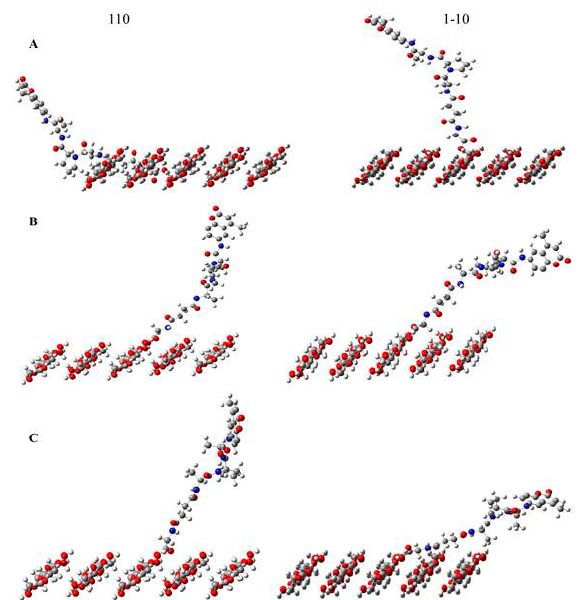
Figure 8. The tripeptide substrate anchored on the five-chain 110 or 1–10 surface of cellulose in the following rotamer positions: ( A ) gauche-gauche; ( B ) gauche-trans; and ( C ) trans-gauche.